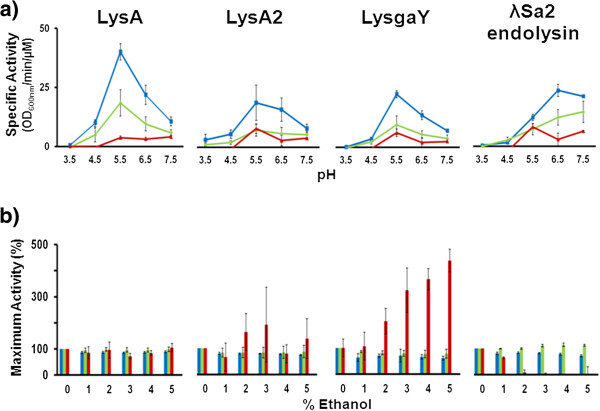
Turbidity reduction analysis of LysA, LysA2, LysgaY and λSa2 endolysin against multiple lactobacilli in a range of pH and ethanol concentrations. a) Effect of pH on turbidity reduction specific activities (OD600nm/min/μM; as described by [49]). b) Effect of ethanol on lysin activity (normalized to specific activity achieved at pH 5.5 in panel a). Live cells of L. fermentum isolate 0605-B44 (blue), L. fermentum isolate BR0315-1 (green), and L. brevis isolate 0605–48 (red) were used as substrate. Data represent the average of three experiments (n=3) ± SEM.